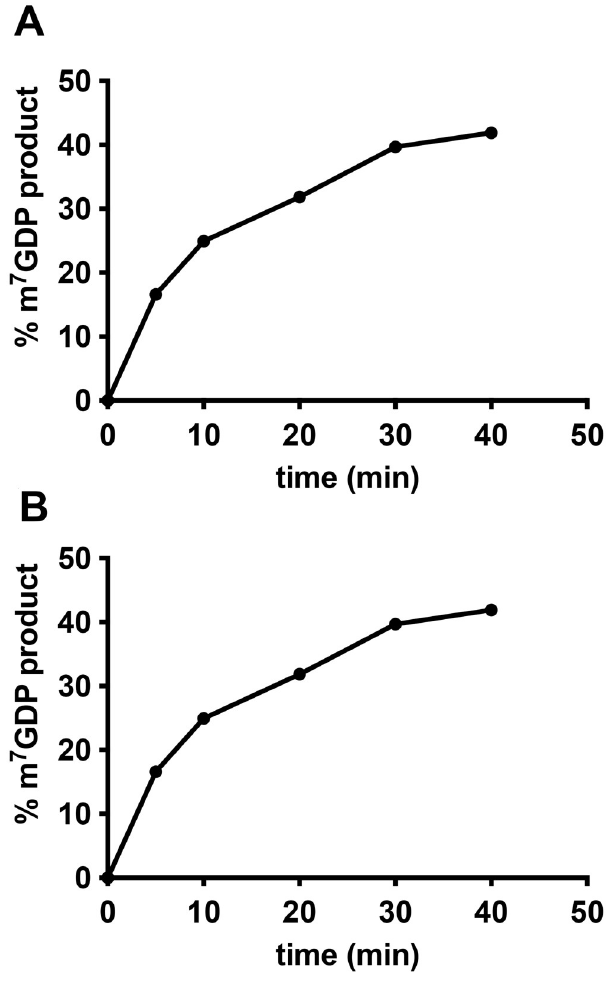
Fig 5. Recombinant L375 mRNA decapping activity increases with time and enzyme concentration. (A) 60 ng of recombinant L375 was incubated with 0.02 pmol 32 P-cap-labeled actin RNA substrate in decapping buffer at 37˚C for the time indicated on the graph. After separation of the reaction products on PEI-cellulose TLC plates, the percentage of m 7 GDP released was calculated by PhosphorImager analysis. (B) The indicated amount of recombinant L375 was added to 0.02 pmol 32 P-cap-labeled actin RNA substrate for mRNA decapping assays performed as in Fig 2B. The percentage of m 7 GDP liberated was quantified using a